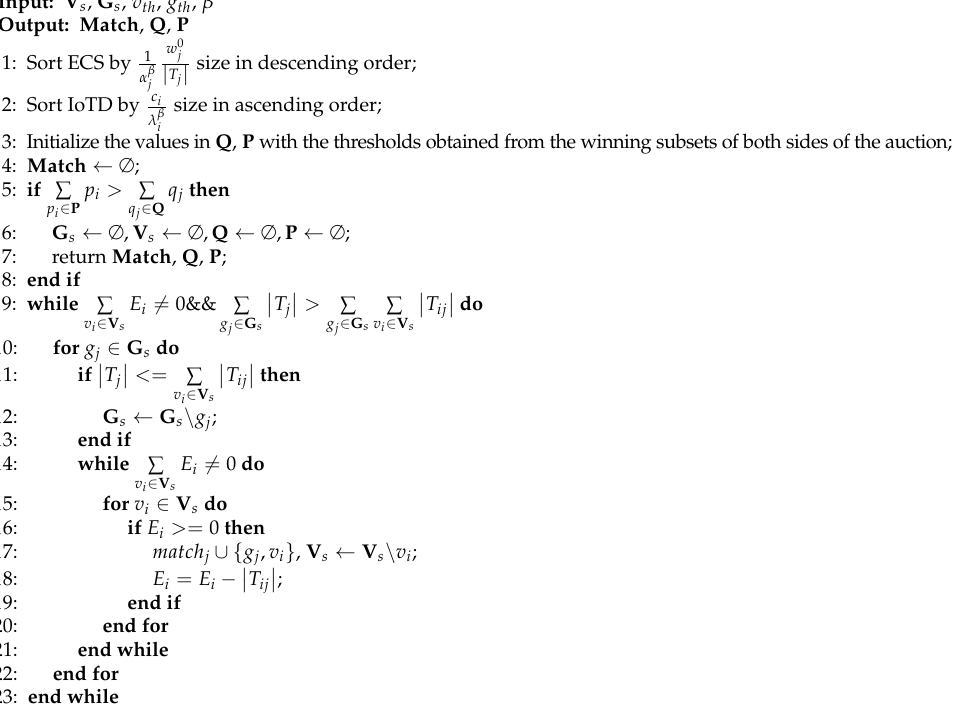
Algorithm 3 Dynamic Matching Algorithms to meet electricity demand